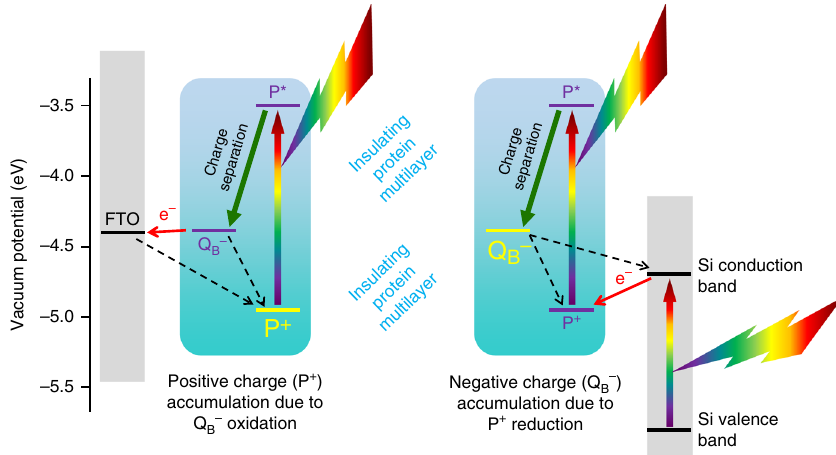
Fig. 3 Photoexcitation and electrochemical activity at the two electrodes. In cells with RC-LH1 proteins (i.e., reaction centre-light harvesting 1 complexes), in the photo-excited protein layers near the FTO ( fl uorine-doped tin oxide) electrode (left), trapped positive charges (initially P + ) accumulate as Q B − formed by intra-RC charge separation (green arrow) donates electrons to the FTO (red arrow). In photo-excited protein layers near the n-Si electrode (right), trapped negative charges (initially Q B − ) accumulate as P + formed by intra-RC charge separation (green arrow) is reduced by the photoactive n-Si electrode (red arrow). In the absence of an electrolyte, these protein/electrode interactions cause the build-up of a potential difference over time. At either electrode, the process responsible for the generation of trapped positive or negative charges would be expected to be in competition with wasteful competing reactions (dashed black